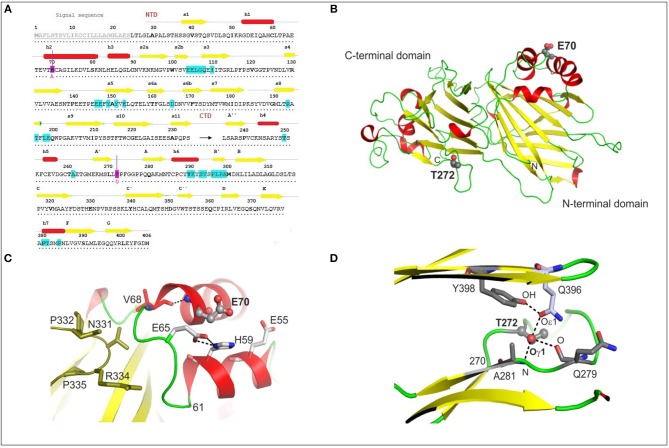
Structural analyses of MHV-68 wtM3 protein. (A) The amino-acid sequence of wtM3 including the N-terminal signal sequence, and the N-terminal (NTD) and C-terminal domains (CTD). Residues here and throughout the text are numbered according to the full-length sequence, beginning with the N-terminal signal sequence. Residues thought to be involved in CCL2 binding are in turquoise (Diaz et al., 2009); those chosen for mutation, E70 and T272, are colored magenta. Secondary structure elements, α-helices and β-strands, are marked as red rectangles and yellow arrows, respectively. (B) The tertiary structure of the 406-residue MHV-68 M3 (PDB ID 1MKF). Residues E70 and T272, selected for mutation to A and G, respectively, are shown as balls and sticks. (C) The conformation of E70 and the surrounding residues E55, E65, H59, and V68 (shown as sticks) in the structure of wtM3. The hydrogen bond between the E70 N and V68 O is shown as a dashed line. Residues 331–335 from the neighboring M3 molecule in the M3 dimer are shown in olive green. (D) The hydrogen bond network formed by T272 Oγ1 with Q396 Oε1, A281 N, and Q279 O (all shown as sticks) in the wtM3 structure. The hydrogen bond between Q396 Oε1and the phenolic OH group of Y398 is also shown.